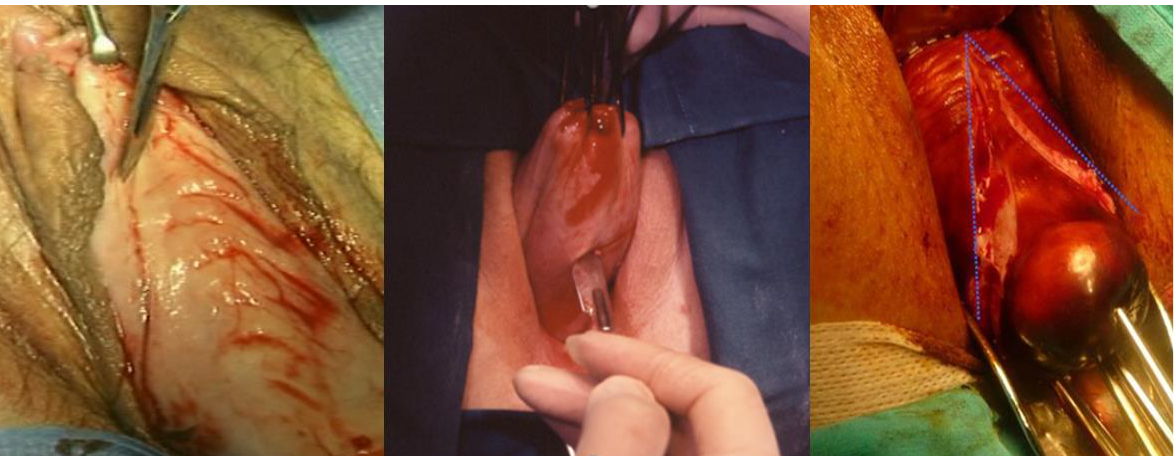
Figure 1. On the left, the incision on the anterior vaginal wall is shown; in the center, the incision on the posterior vaginal wall is shown; on the right, the drop-like anterior vaginal incision in women with cystocele is shown.